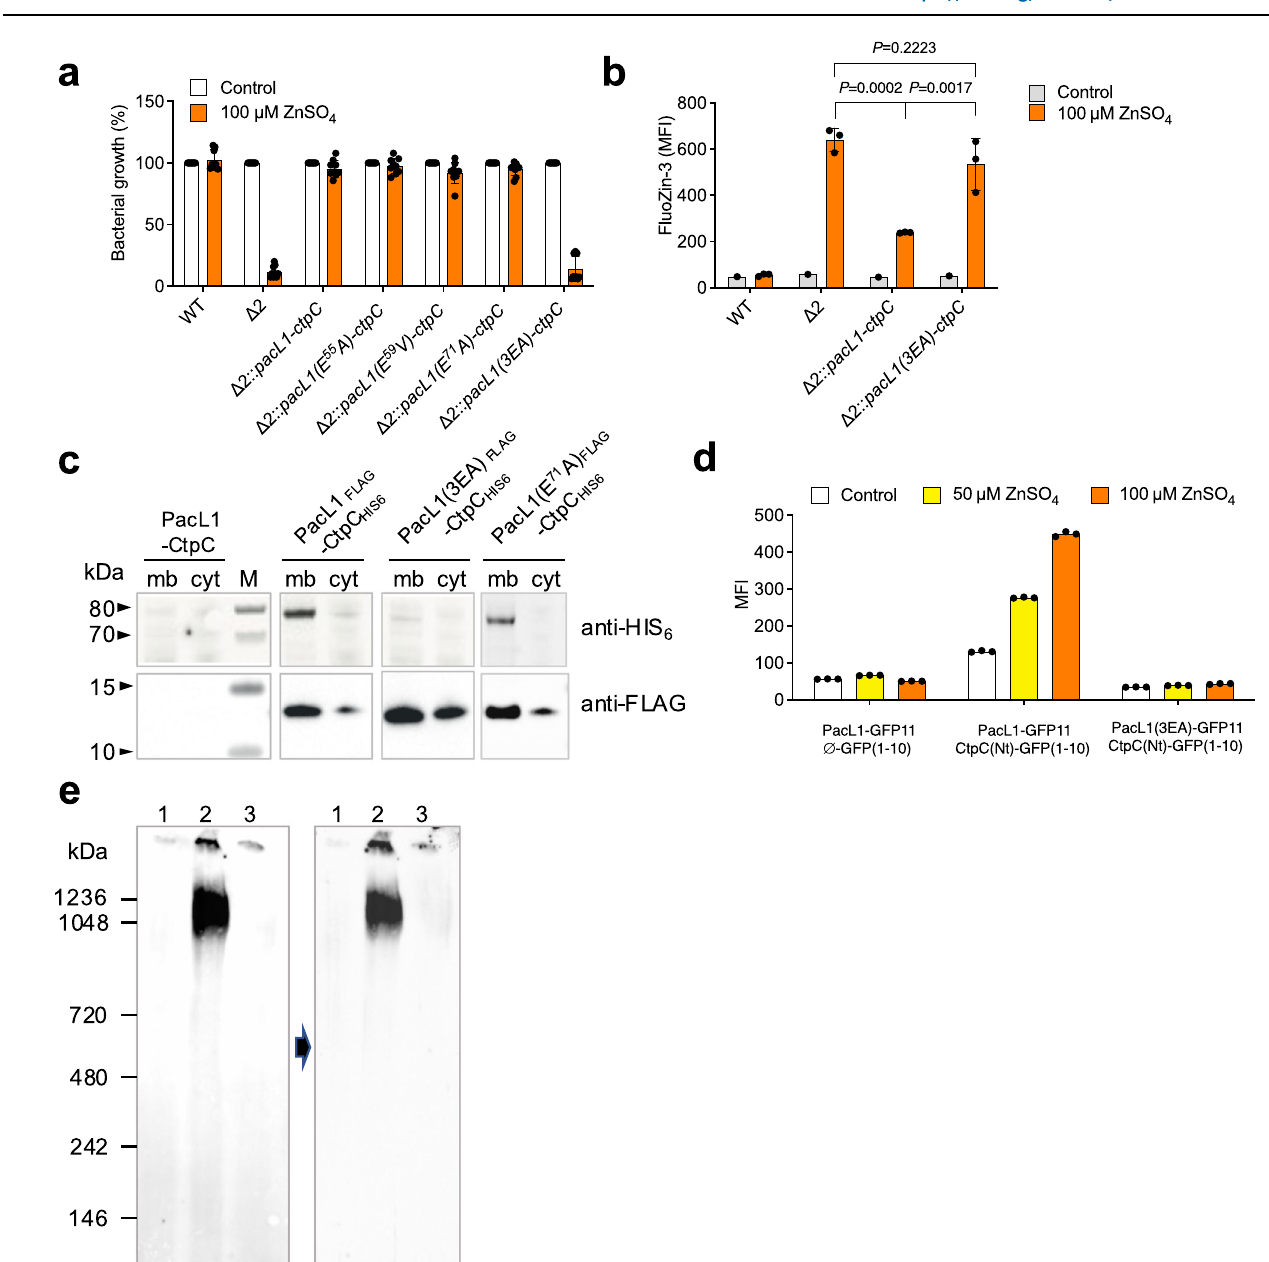
lower membrane was treated for FLAG immune-detection. Data are repre- sentative of 2 independent experiments. d Bipartite split-GFP experiment using M. smegmatis Δ 2 expressing a PacL1-GFP11 fusion protein and control GFP1-10 (left),aPacL1-GFP11fusionproteinandtheCtpCN-terminalregion(M 1 -A 85 )fused to GFP1-10 (middle), or a PacL1(3EA)-GFP11 fusion protein and the CtpC N-terminal region (M 1 -A 85 ) fused to GFP1-10 (right). Bacteria were grown in complete 7H9 medium supplemented with the indicated amounts of zinc. Fluorescence was recorded by fl ow cytometry and expressed as mean fl uor- escent intensity (MFI). Data ( n =3 technical replicates) are representative of 2 independentexperiments. e Blue-nativegelanalysisofmembrane proteinsfrom M. smegmatis Δ 2 expressing recombinant PacL1 and CtpC (lanes 1), HIS 6 -tagged CtpC and FLAG-tagged PacL1 (lanes 2), or HIS 6 -tagged CtpC and FLAG-tagged PacL1(3EA) variant (lanes 3). Proteins were extracted from M. smegmatis mem- brane fractions with 0.25% DDM, separated on native gel, transferred onto PVDF membranes and revealed by FLAG (left panel) or HIS 6 (right panel) immune- detection.Black arrow indicates membrane stripping.Data arerepresentative of two independent experiments. Reverse immune-detection (HIS 6 followed by FLAG) led to similar results. Source data are provided as a Source Data fi le.